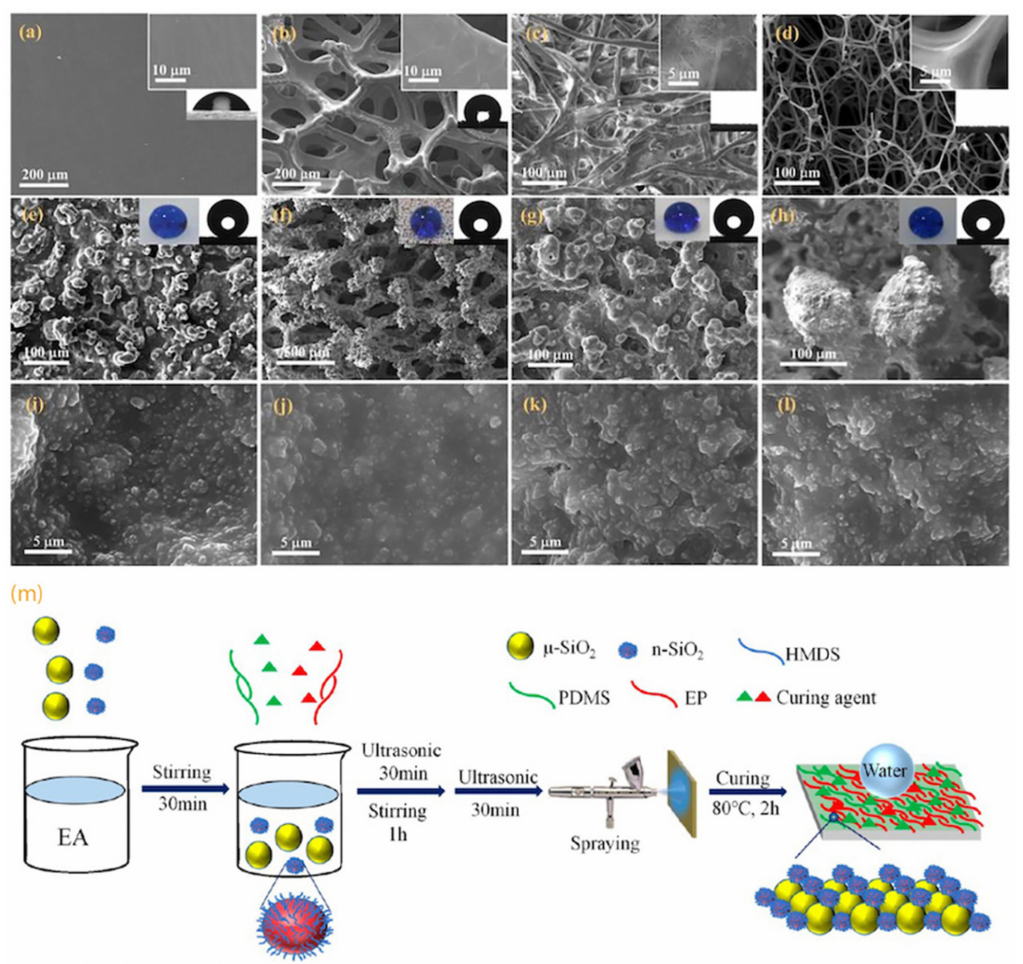
Figure 9. SEM images of untreated of: ( a ) glass; ( b ) copper foam; ( c ) filter paper; ( d ) sponge; ( e – h ) surface morphology of the corresponding epoxy resin+PDMS@SiO 2 -coated samples; and ( i – l ) SEM images of the coated samples at higher magnification (Reprinted from [44] with permission from Elsevier). ( m ) Schematic illustration of the spraying process (Reprinted with permission from [43]. Copyright {2021} American Chemical